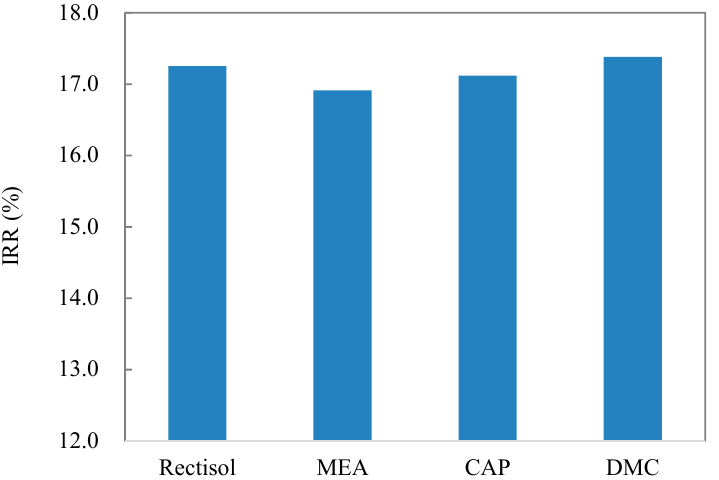
Figure 11. Internal rate of return of CTEG process with different CO 2 capture technologies.